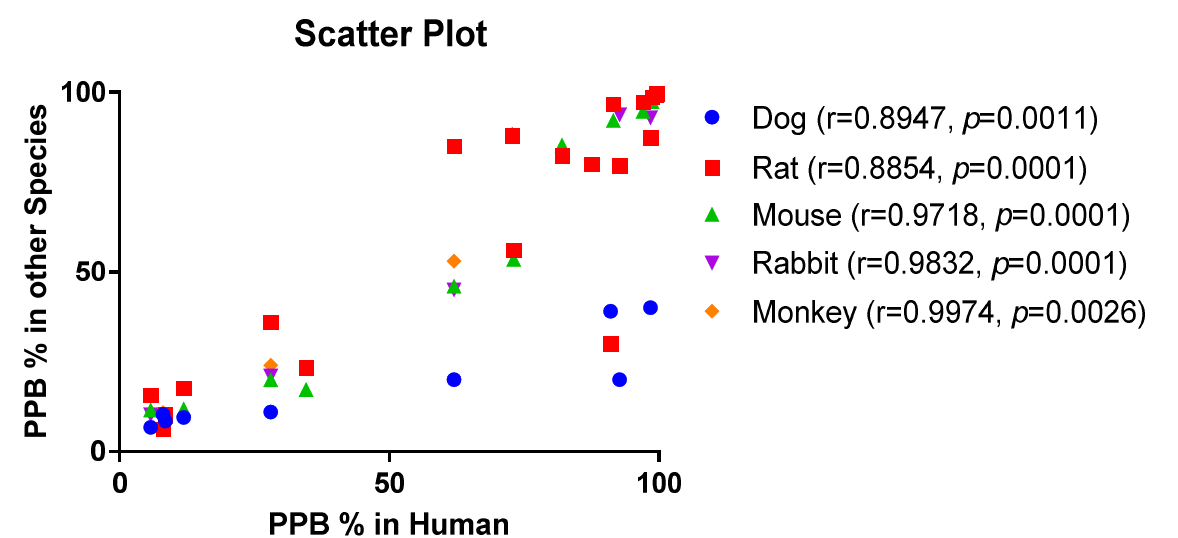
Figure 5. Scatter plot depicting the correlation between % plasma protein binding in humans and other species. r is the Pearson correlation coefficient.